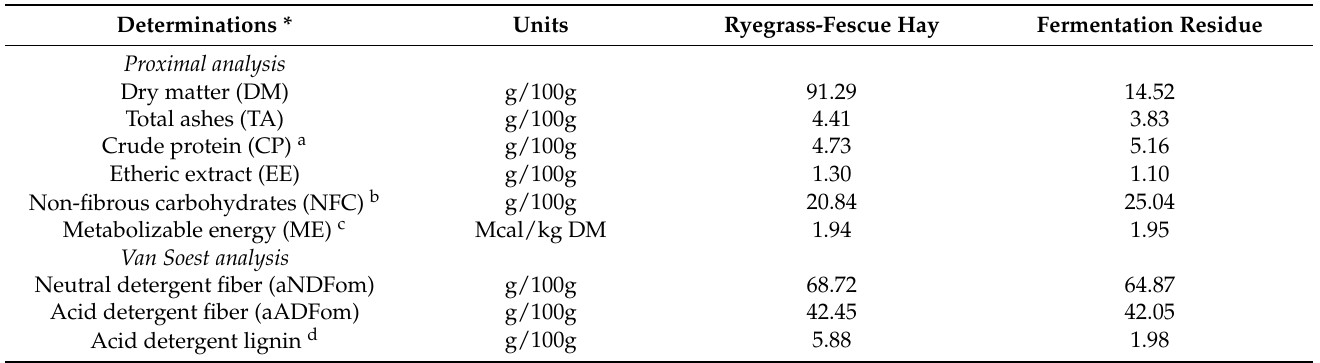
Table 1. Chemical composition of ryegrass fescue hay before and after 14 day SSF.